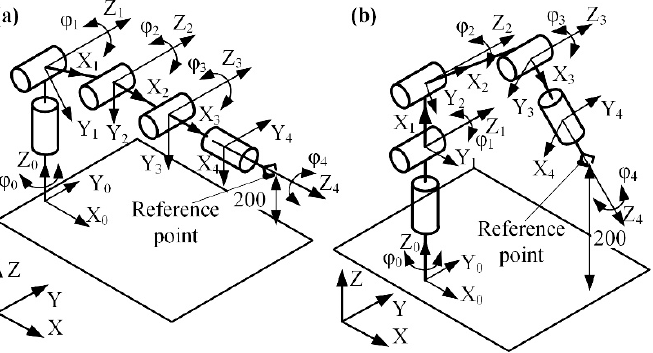
Figure 5. Start positions of the robot used for the measurements of gripper vibrations: ( a ) maximum peripheral reach on extended position, ( b ) compacted position. In both cases, the reference point was distanced from the z -axis origin by 200 mm.